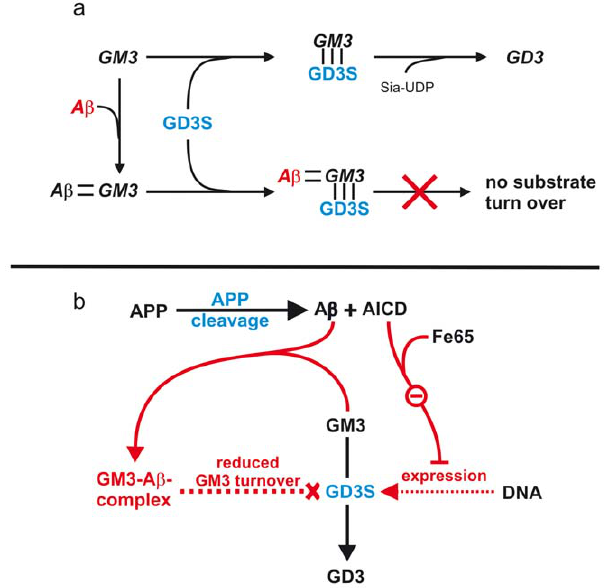
Figure 4. Molecular mechanisms of APP cleavage products in the regulation of GD3S enzyme activity. ( A ) In absence of A b peptides a -series ganglioside GM3 binds to GD3S and is converted to the b -series ganglioside GD3. In presence of A b , A b binds ganglioside GM3, forming an A b -GM3 complex. This complex still binds to GD3S, but cannot be converted to GD3. ( B ) Dual function of A b and AICD in GD3S regulation. A b reduces enzyme activity of GD3S by forming an A b -GM3 complex, resulting in reduced turnover of GM3 to GD3. AICD binds the adaptor protein Fe65 and reduces GD3S gene transcription, which also results in reduced turnover of GM3 to GD3.